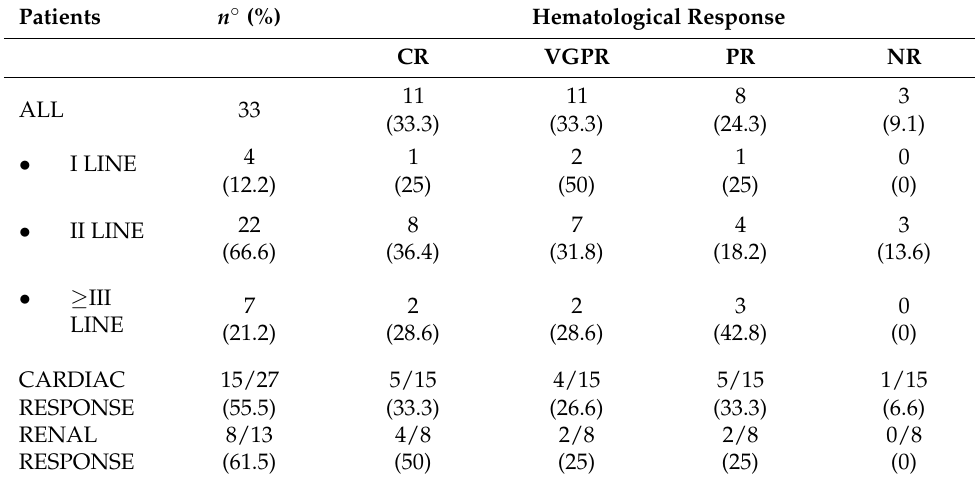
Table 2. Hematological response and organ